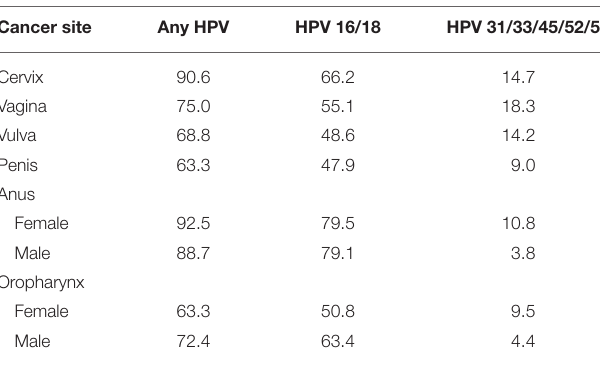
TABLE 1 | Input: proportion (%) of cancers attributable to any HPV and by HPV type in the United States in 2008–2010 (1). Cancer